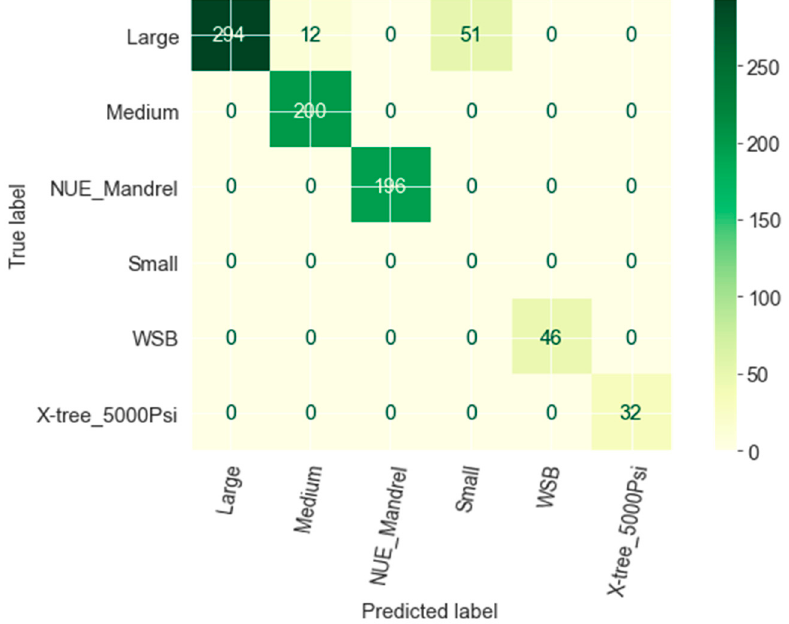
Figure 8. RF size selection confusion matrix (true label vs. predicted label).